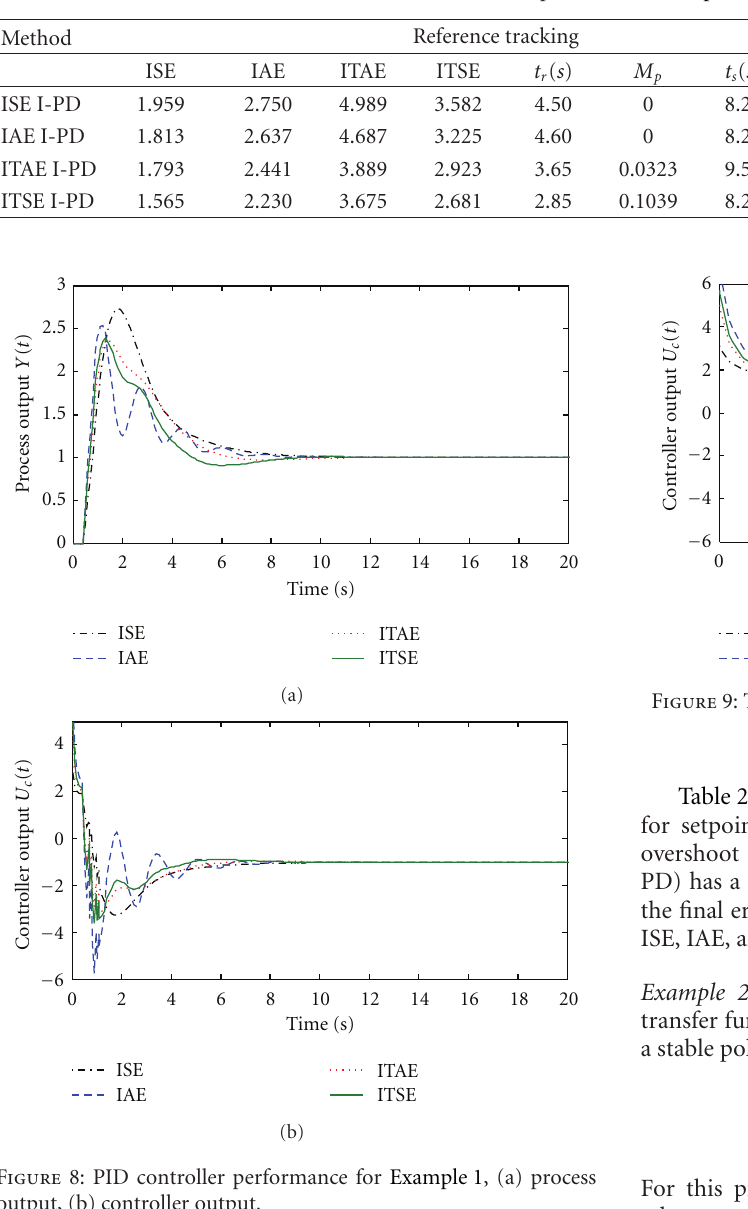
Table 2: Performance comparisons for Example 1 with I-PD controller.